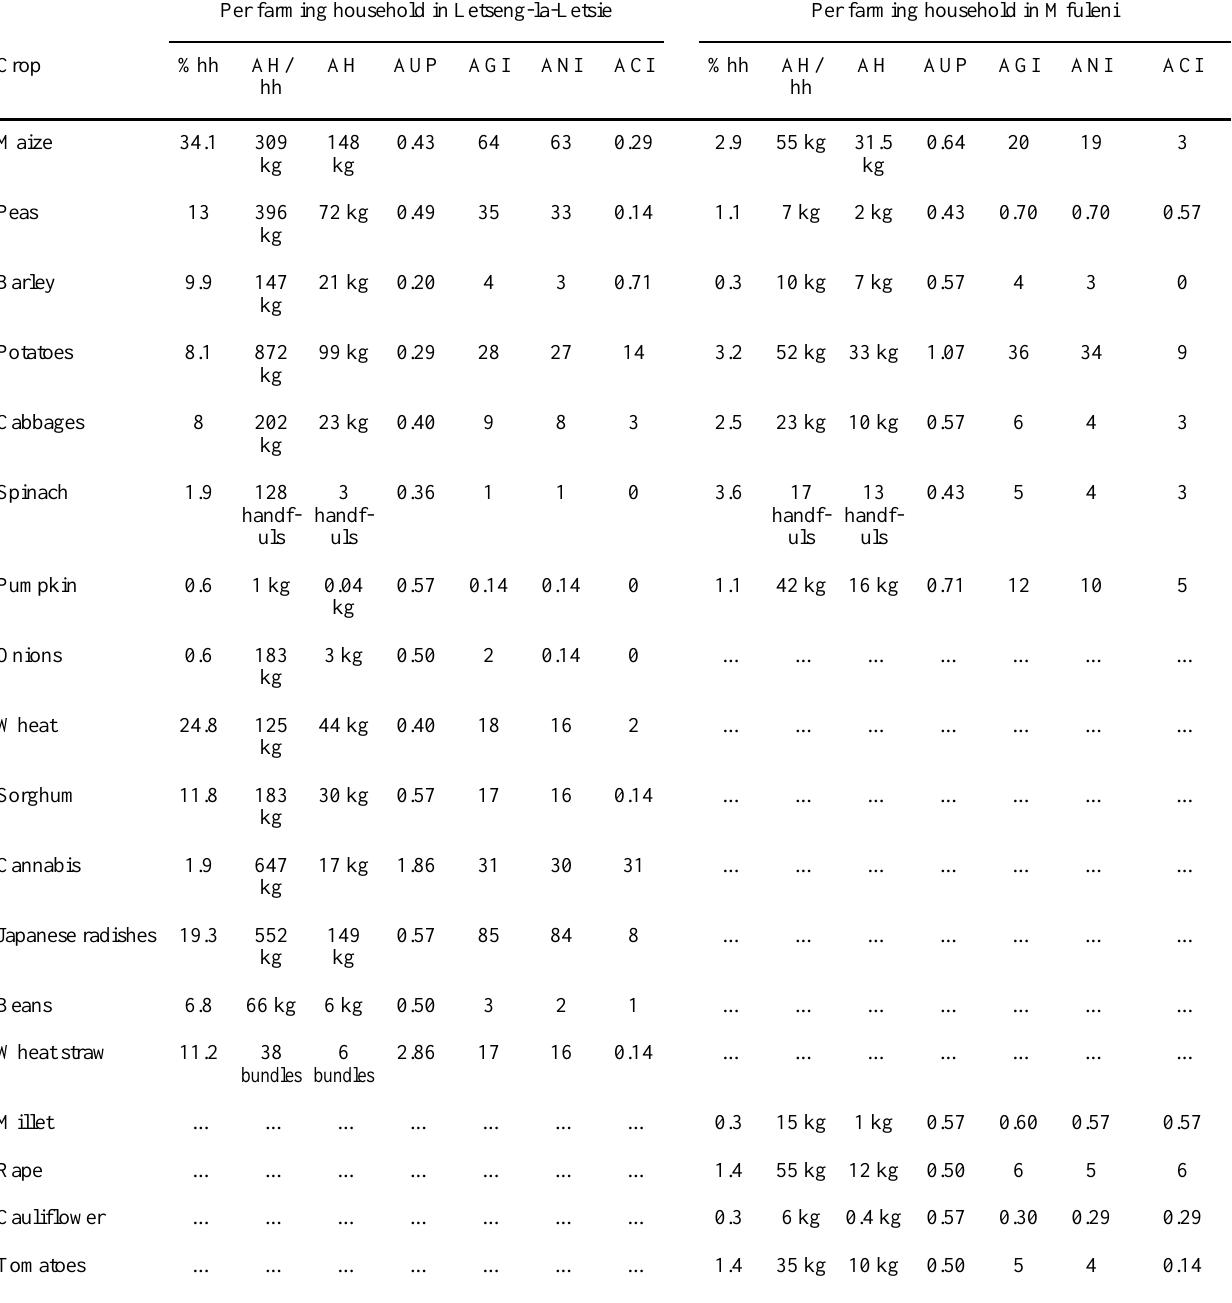
Table 2 . Average agricultural production over the previous year around Letseng-la-Letsie and Mfuleni. % hh = percentage of households growing the crop, AH/hh = average harvest per growing household, AH = average harvest, AUP = average unit price in U.S. dollars, AGI = average gross income per year in U.S. dollars, ANI = average net income per year in U.S. dollars, and ACI = average cash income per year in U. S.